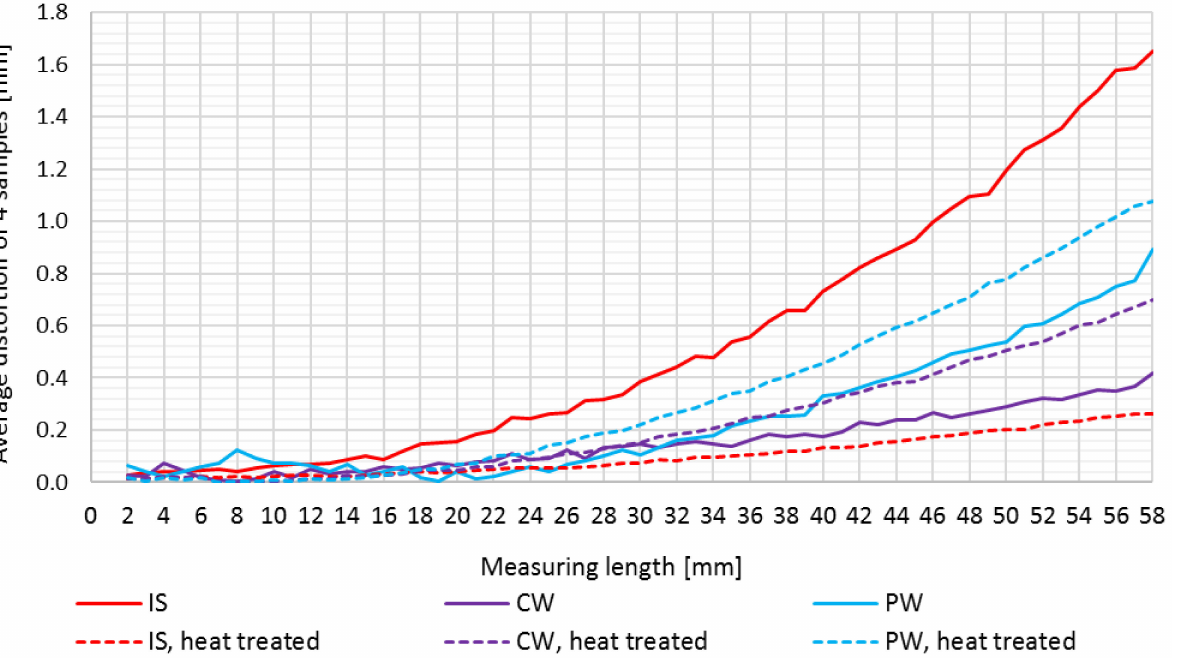
Figure 18. Measured average distortion of four samples, depending on the type of post treatment.